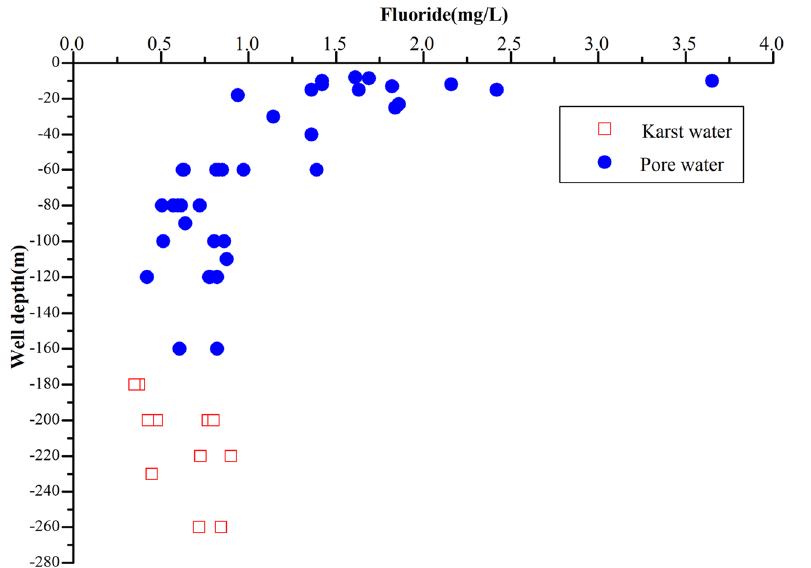
Figure 4. Relationship between fluoride concentrations and well